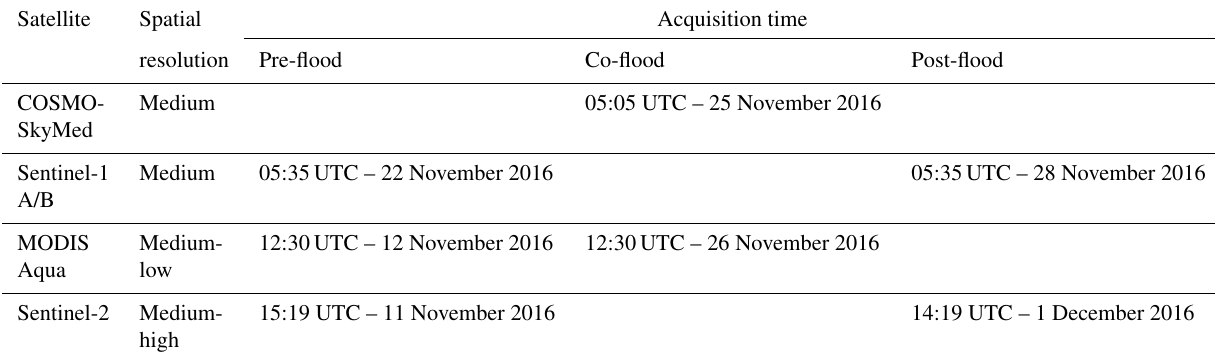
Table 2. Resume of satellite data in relation with the flood stage. Satellite